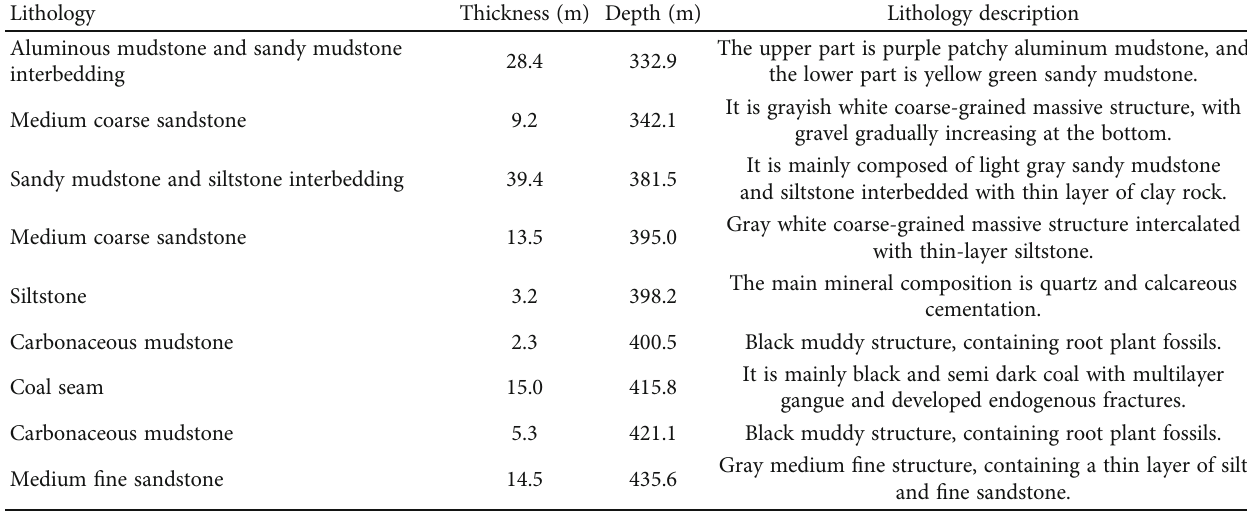
Figure 1: Relative position relationship of the 8211 working face. Table 1: Lithology of the 8211 working